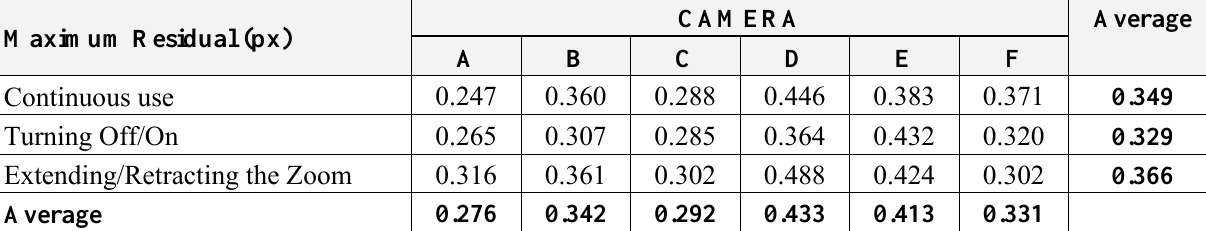
Table 9. Maximum marking residual (in pixels) obtained in the 372 calibrations performed in all six cameras